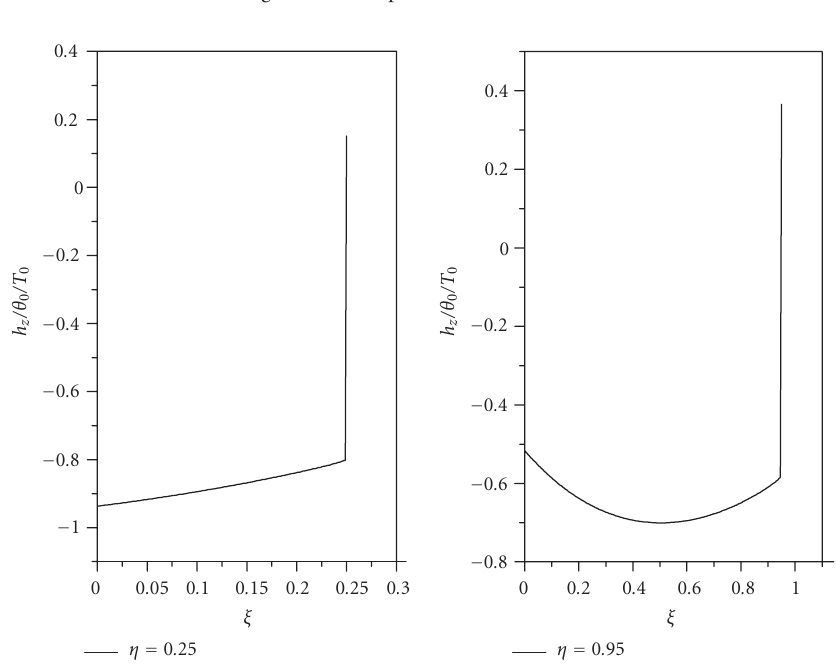
Figure 3.2. Temperature versus distance.